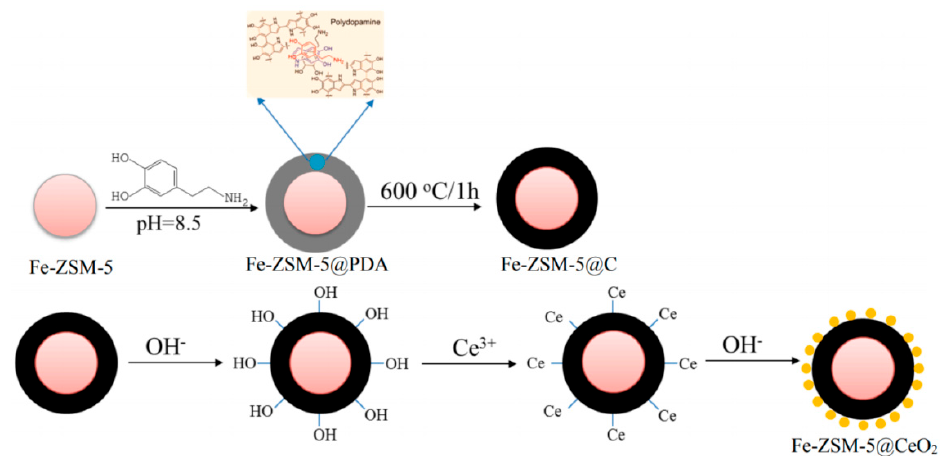
Figure 20. The PDA (Personal Digital Assistant)-assisted route for Fe-ZSM-5@CeO 2 preparation [118].